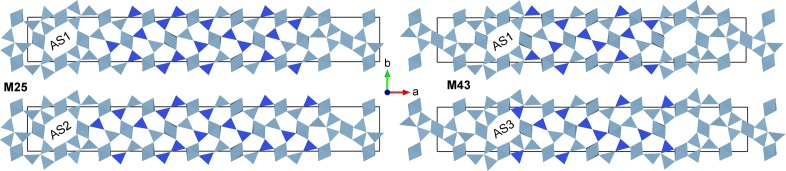
Geometrically optimized (PBEsol-D) structure models of M25 (left) and M43 (right) with different Al/Si ordering patterns (AS1, AS2, AS3).